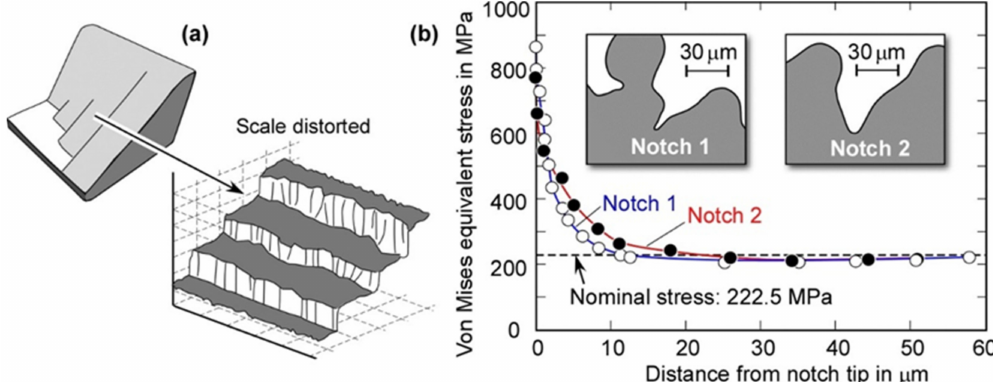
Figure 4. Surface roughness in L-PBF, as-built state: ( a ) staircase effect, according to [29], simplified; ( b ) as-built surface roughness of L-PBF Ti–6Al–4V, according to